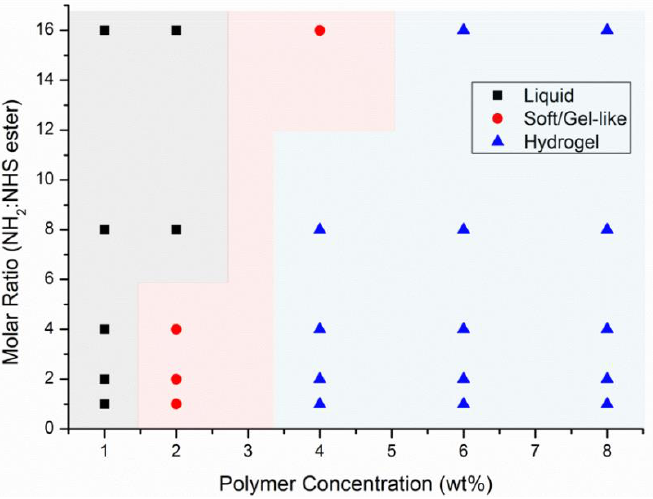
Figure 2. A phase plot of the library of hydrogels.